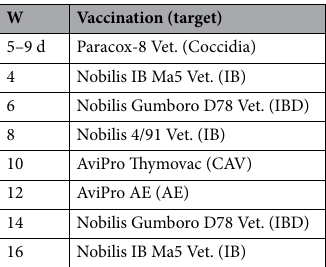
Table 1. Vaccination programme. Note the absence of E. coli prophylaxis. AE avian encephalomyelitis, CAV chicken anaemia virus, d day, IB infectious bronchitis virus, IBD infectious bursal disease, W week of